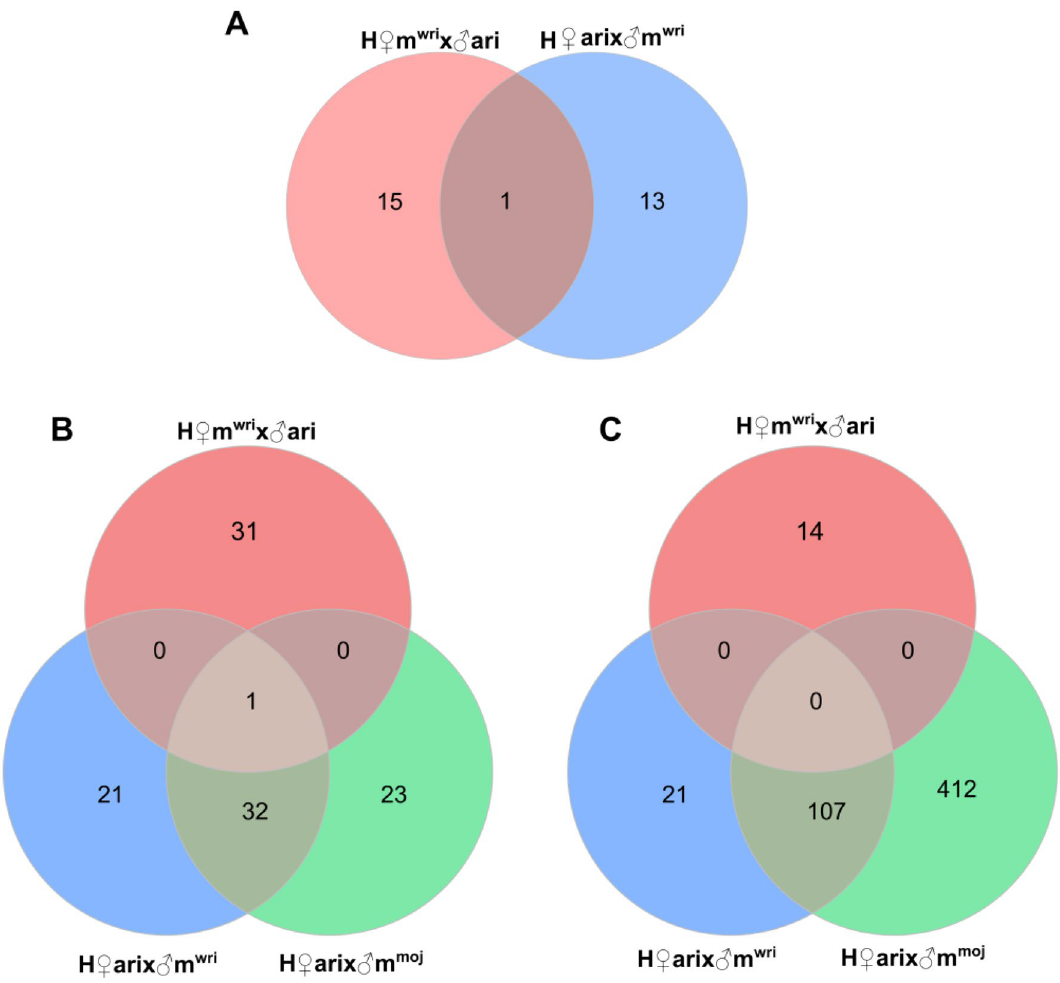
Figure 4. Shared DEGs between hybrids. ( A ) Number of shared overexpressed genes between H ♀ m wri ♂ ari and H ♀ ari ♂ m wri females. ( B ) Number of shared overexpressed genes between H ♀ m wri ♂ ari, H ♀ ari ♂ m wri and H ♀ ari ♂ m moj males. ( C ) Number of shared underexpressed genes between H ♀ m wri ♂ ari, H ♀ ari ♂ m wri and H ♀ ari ♂ m moj males. A Venn diagram was generated using the VennDiagram package (version 1.6.20) in R 79